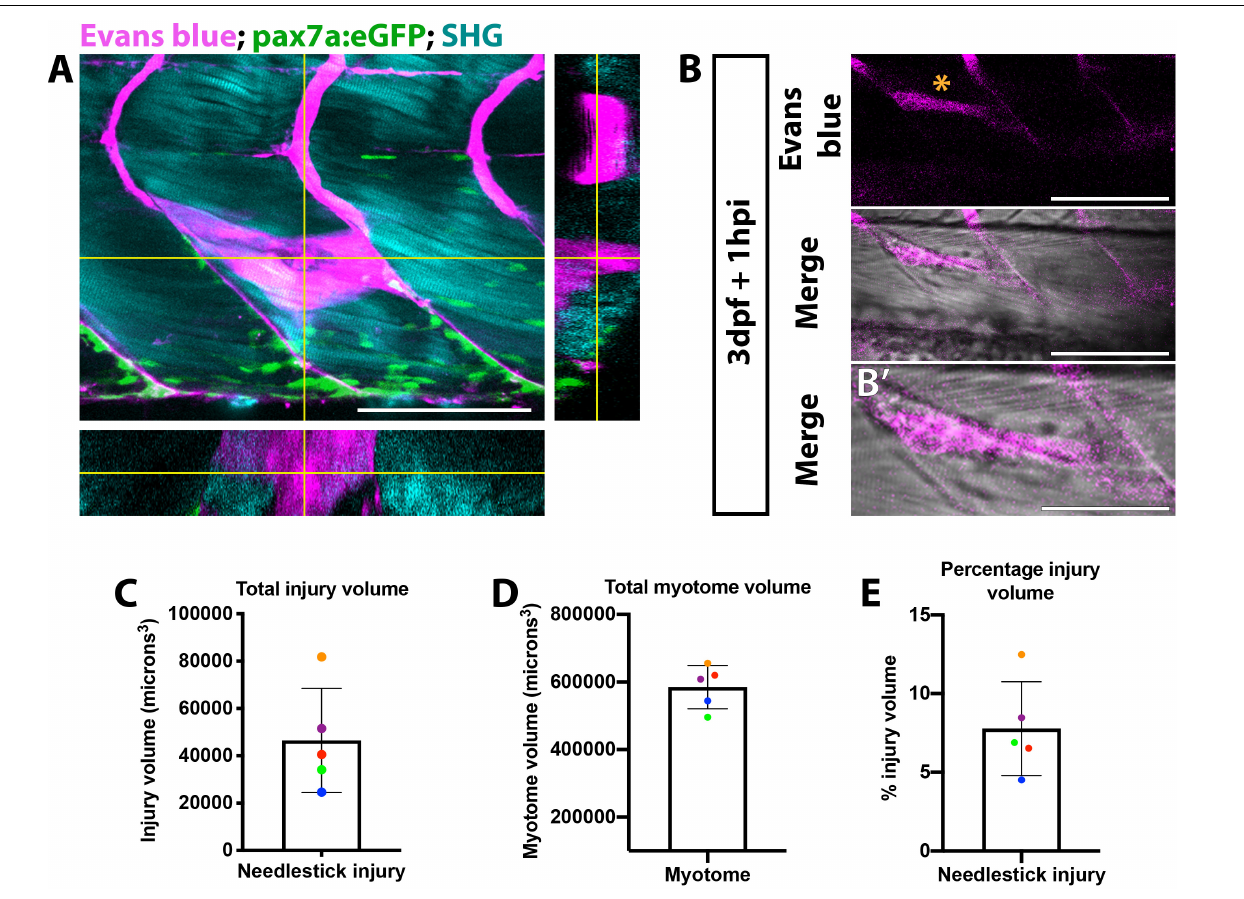
FIGURE 1 | Visualization of muscle injury using Evans blue reveals low variability of injury size caused by needlestick. Evans blue labeling of damaged muscle (A,B) was visualized on a multiphoton microscope and localizes with perturbed myofibre morphology (B’) at needlestick wounds (asterisk) in 3 dpf larvae at 1 h post-injury. Maximum projection (A) with orthogonal sections in planes YZ (right) and XZ (bottom) showing Evans blue staining relative to myofibres (visualized by second harmonic generation; SHG) and pax7a:eGFP expressing muSCs. Volumetric measure of the (C) total myotome and (D) injured region were calculated by measuring injury size for each section, and the percentage injury size of the total myotome calculated (E) . Each larvae ( n = 5) has been color coded to highlight the variance in myotome and injury size. Error bars display standard deviation. Scale bars: 100 µ m (A,B) , 50 µ m (B’) .